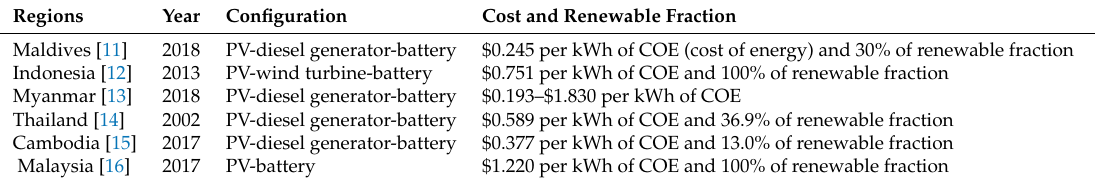
Table 3. Examples of the suggested configuration of renewable energy production systems in Southeast